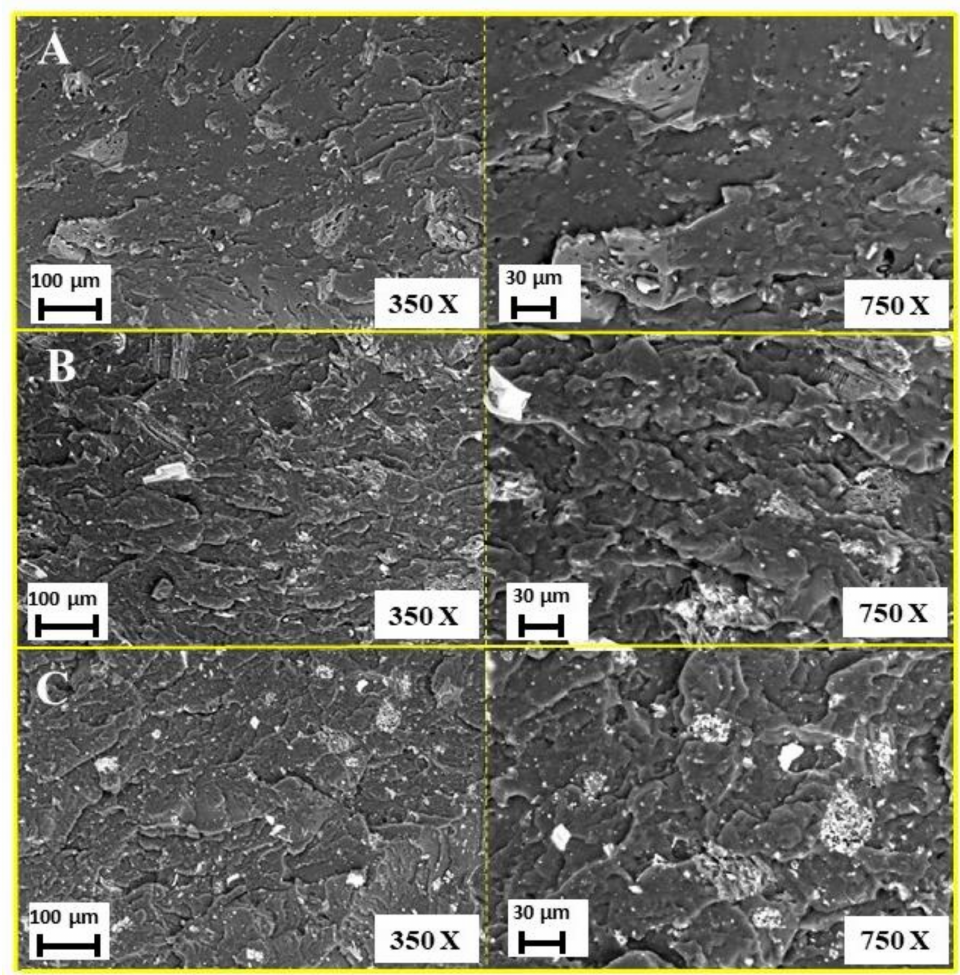
Figure 3. SEM images at different magnification (350 × and 750 × ) of EVA + 20 wt% of: BC low ( A ); BC medium ( B ); and BC high ( C